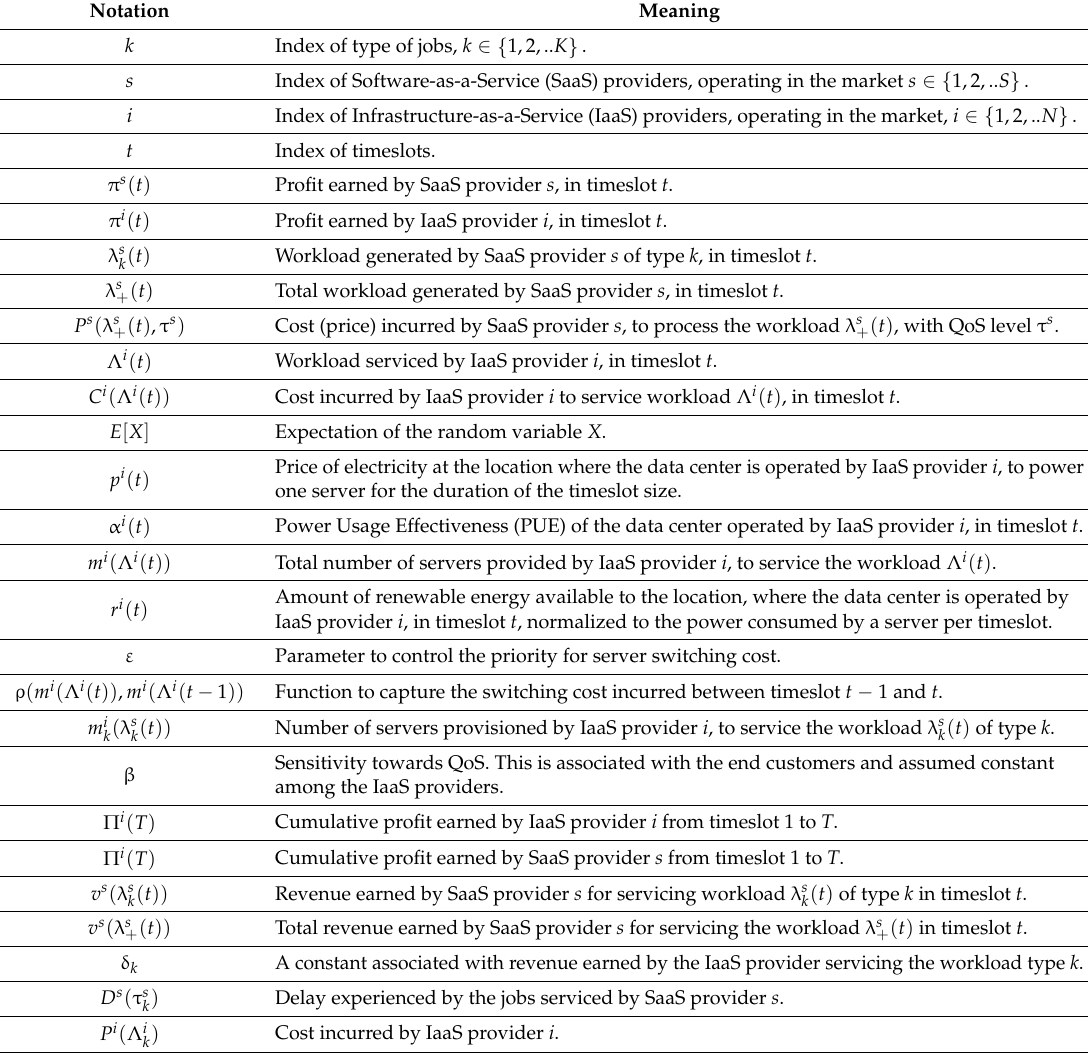
Table 1. The notations used for the model to capture the cloud service